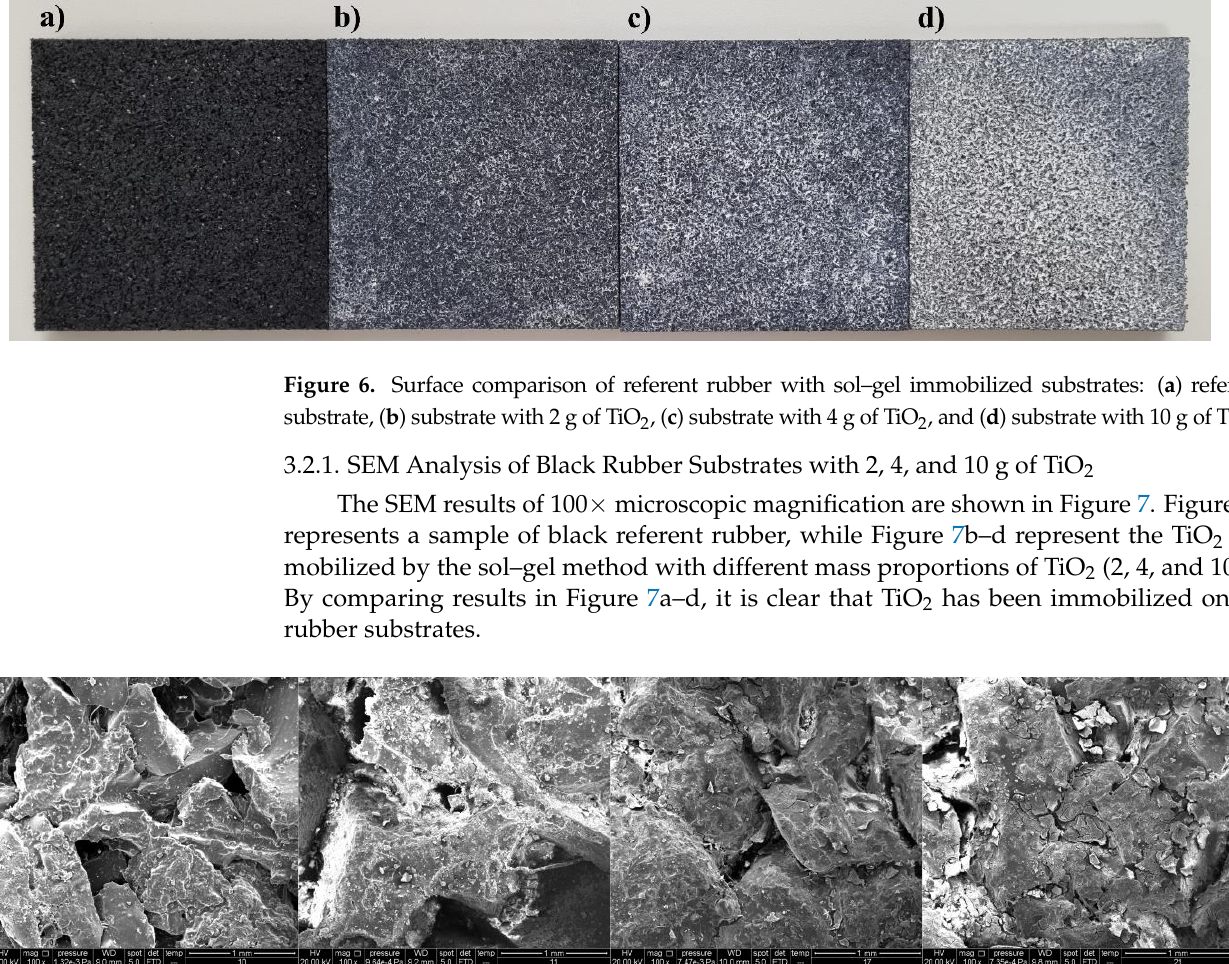
Figure 6. Surface comparison of referent rubber with sol – gel immobilized substrates: ( a ) referent substrate, ( b ) substrate with 2 g of TiO 2 , ( c ) substrate with 4 g of TiO 2 , and ( d ) substrate with 10 g of TiO 2.